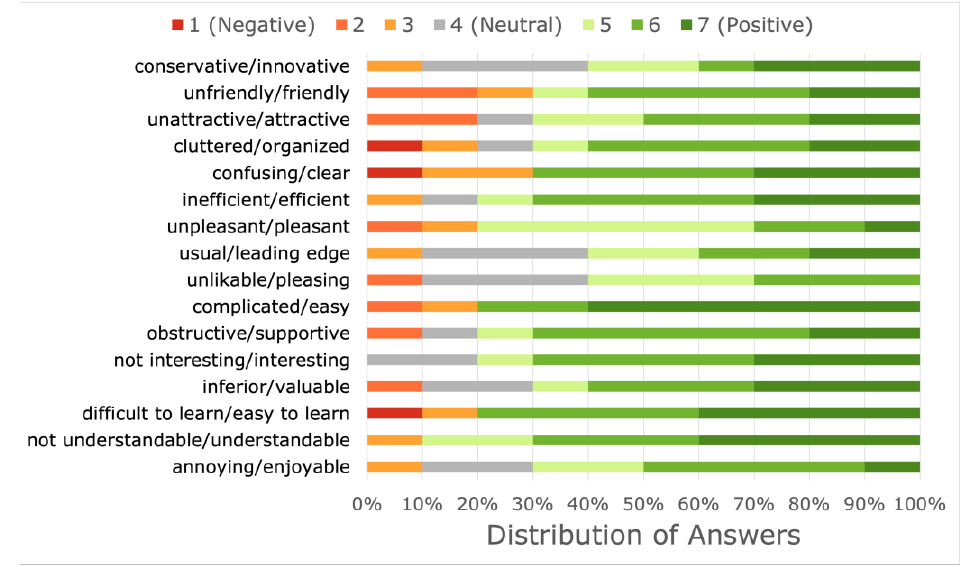
Figure 8. User experience questionnaire evaluation for selected questions. Red and orange colors indicate negative assessments, gray indicates neutral responses and green colors indicate favorable assessments, characterized by specific adjectives mentioned in the figure.